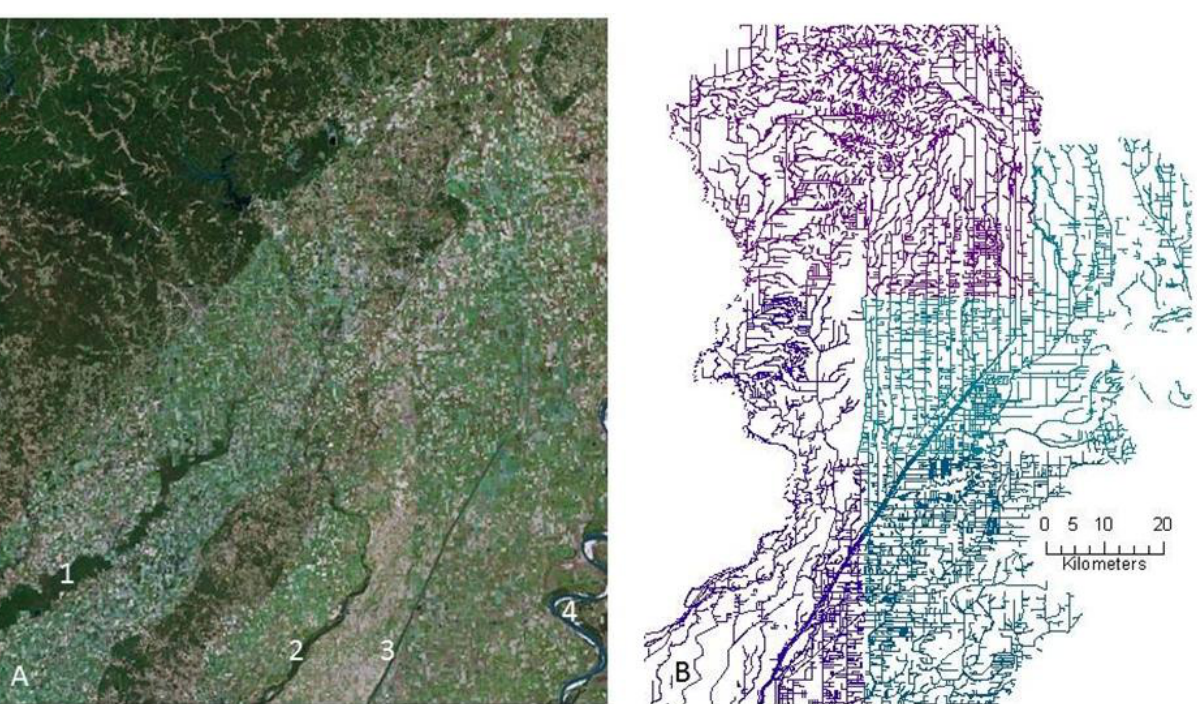
Figure 1. (a) Satellite photo showing the intersection of the Mississippi Alluvial valley and the eastern foothills of the Ozark Mountains on the border of Missouri and Arkansas, USA. The Black River (1, lower left) and the Saint Francis River (2, center) both have (cid:75)(cid:72)(cid:68)(cid:71)(cid:90)(cid:68)(cid:87)(cid:72)(cid:85)(cid:86)(cid:3)(cid:79)(cid:92)(cid:76)(cid:81)(cid:74)(cid:3)(cid:76)(cid:81)(cid:3)(cid:87)(cid:75)(cid:72)(cid:3)(cid:50)(cid:93)(cid:68)(cid:85)(cid:78)(cid:3)(cid:73)(cid:82)(cid:82)(cid:87)(cid:75)(cid:76)(cid:79)(cid:79)(cid:86)(cid:3)(cid:68)(cid:87)(cid:3)(cid:87)(cid:75)(cid:72)(cid:3)(cid:87)(cid:82)(cid:83)(cid:3)(cid:79)(cid:72)(cid:73)(cid:87)(cid:15)(cid:3)(cid:68)(cid:86)(cid:3)(cid:90)(cid:72)(cid:79)(cid:79)(cid:3)(cid:68)(cid:86)(cid:3)(cid:76)(cid:81)(cid:3)(cid:38)(cid:85)(cid:82)(cid:90)(cid:79)(cid:72)(cid:92)(cid:182)(cid:86)(cid:3)(cid:53)(cid:76)(cid:71)(cid:74)(cid:72)(cid:15)(cid:3)(cid:87)(cid:75)(cid:72)(cid:3) semi-forested area between the two rivers. The historic floodplains of their tributaries are clearly visible as non-forested pasture among the foothills. What remains of the Little River (3) is seen as a straight line between the Saint Francis River and the Mississippi River (4, bottom right corner). Much of the source water for both the Black and Saint Francis originates in closed canopy forest, and there is a high percentage of stream canopy coverage in the upland areas pastures. In contrast, the row cropping agriculture predominant in the lowlands creates a treeless landscape. The different colored specks are each individual fields bordered on at least two sides by a drainage ditch. (b) Stream diagram of the right half of Figure 1A, showing perennial streams between the Saint Francis River and the Mississippi River. The familiar dendritic and pinnate stream patterns at the top of the image changes to a trellis pattern of drainage ditches reflecting the change in topology and related increases in land use